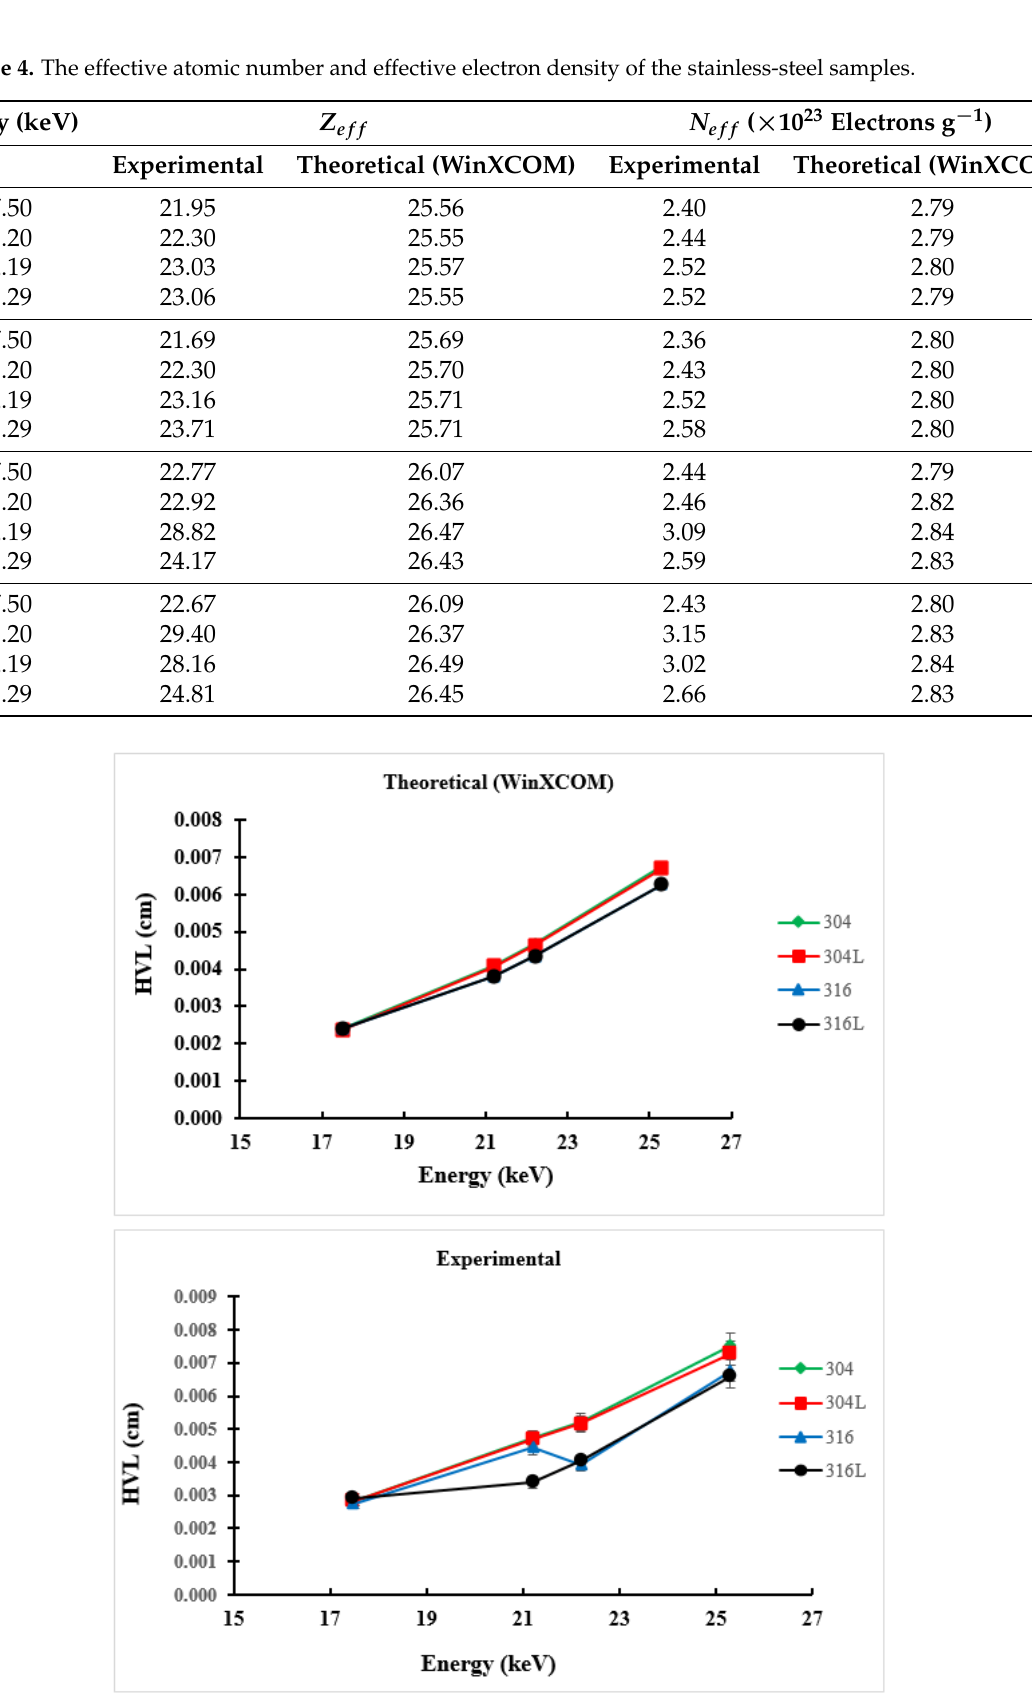
Figure 3. Variation in theoretical and experimental HVL for 304, 304L, 316 and 316L stainless-steel materials with photon energy in the range 17.5–25.29